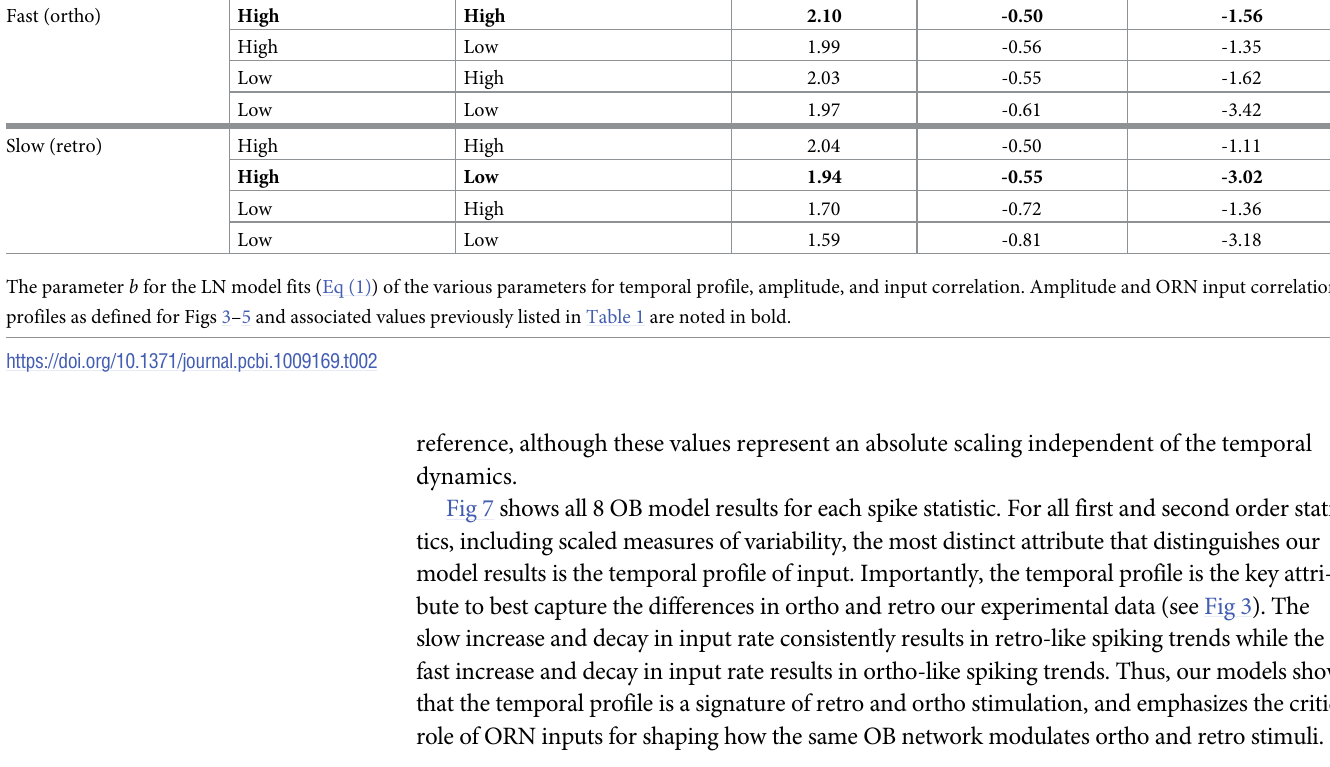
Table 2. Parameter b for LN model fits to MC spiking statistics in Fig 6.